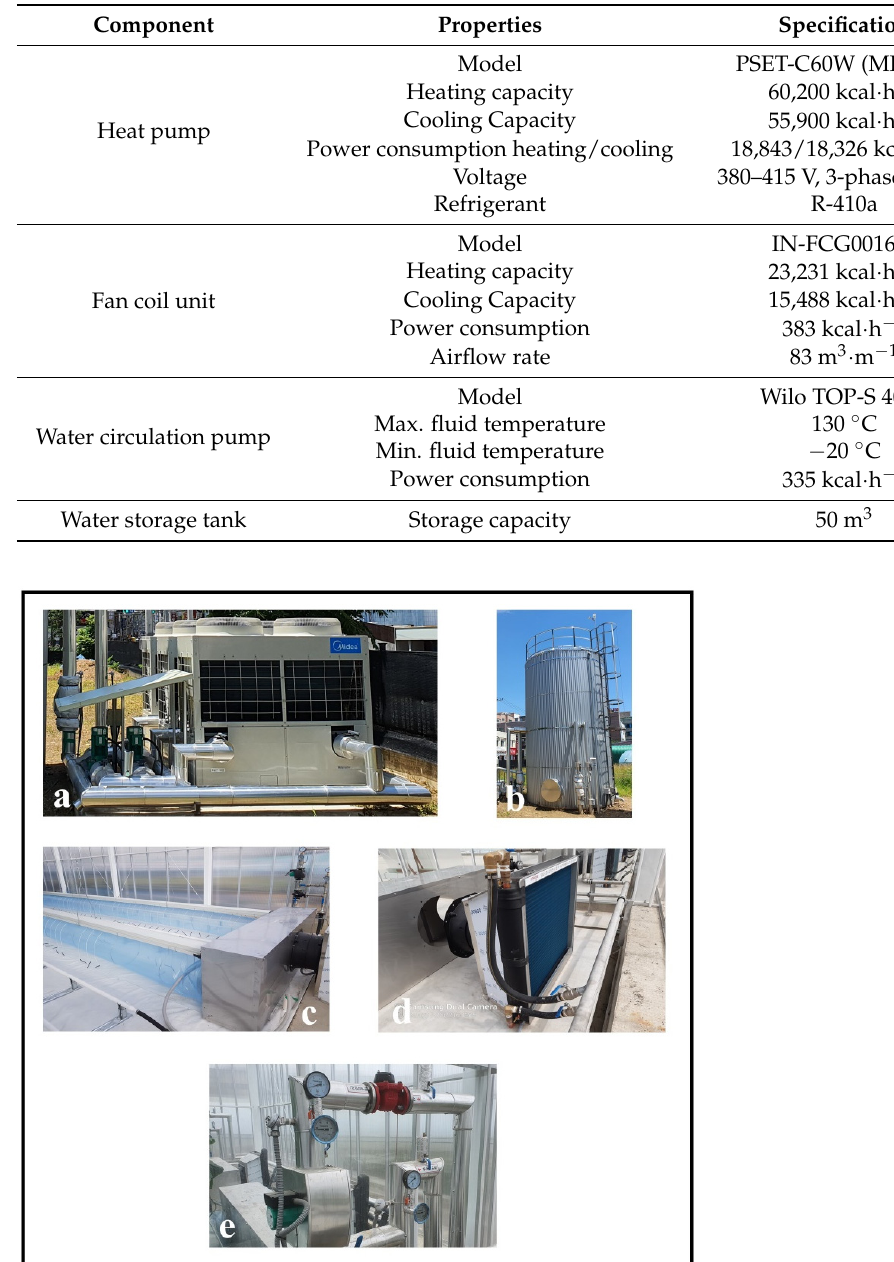
Figure 4. Diagram of AWHP system. 3. Results and Discussion The microclimate of the greenhouse and the efficiency of the heat pump system de- pend on the greenhouse structural design, including shape, cladding, and energy screen material. Ambient climate, especially solar radiation and temperature, are the key param- eters that affect the cooling and heating energy demand of the greenhouse. From a passive